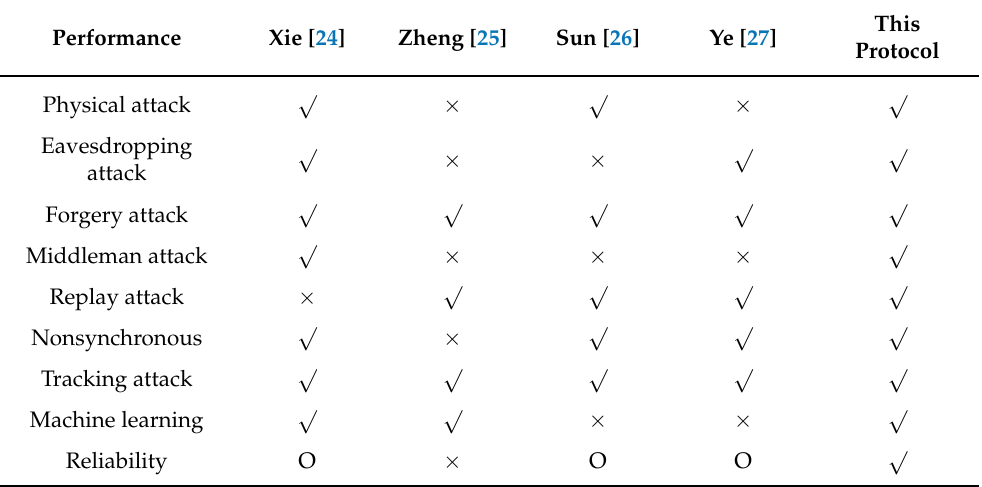
Table 3. Comparison of the RRAM PUF and the previous